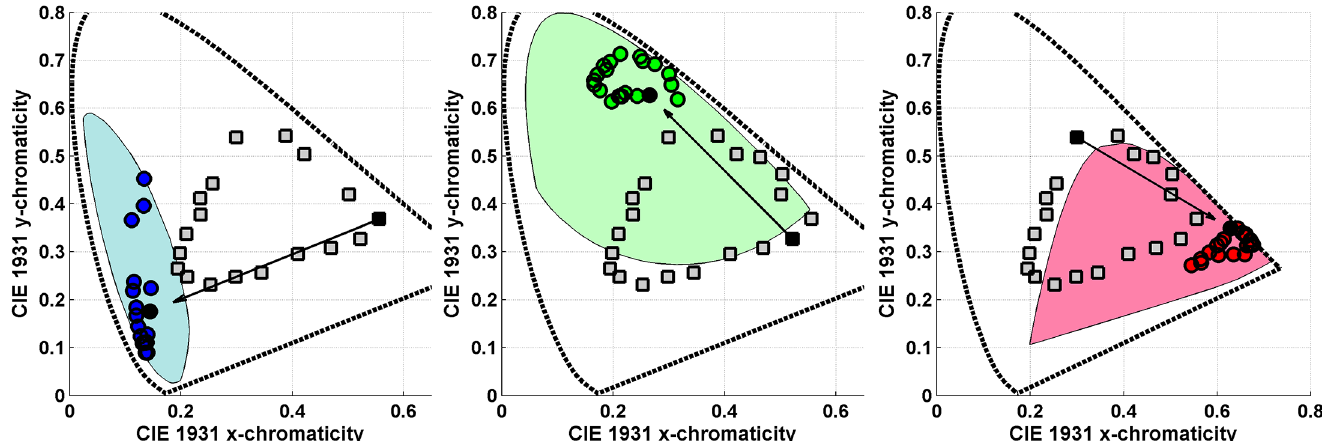
Fig 12. Chromaticity mismatch areas for the neutral-to-blue, neutral-to-green and neutral-to-red illumination conditions. Squares indicate chromaticities of Munsell papers under the neutral (N) illumination. Dots indicate the corresponding chromaticities of the papers under the second illumination. A black square and black dot correspond to the same paper. (Left) Paper #2 under the neutral-to-blue condition. Its chromaticity mismatch area (bluish region) covers the chromaticities of 18 of the 20 Munsell papers. (Centre) Paper #1 under the neutral-to-green condition. Its chromaticity mismatch area (greenish region) covers all 20 Munsell papers. (Right) Paper #8 under the neutral-to-red condition. Its chromaticity mismatch area (reddish region) also covers all 20 Munsell papers.